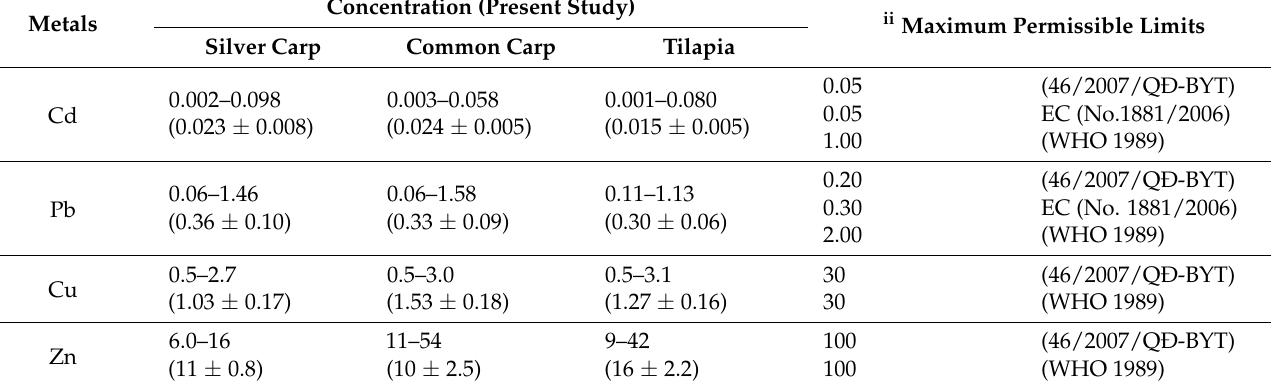
Table 2. Levels of metals in fish muscles in the present study and the maximum acceptable limits (mg/kg ww). The mean values from all sites and the standard error of the mean are shown in parentheses. The values in bold are those that exceed the maximum permissible